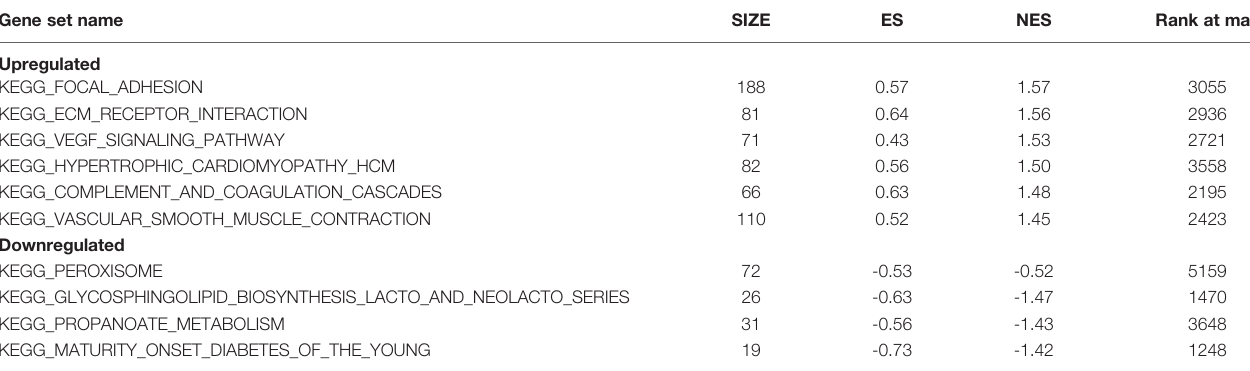
TABLE 3 | Pathway enrichment analysis of DEGs in gastric cancer using